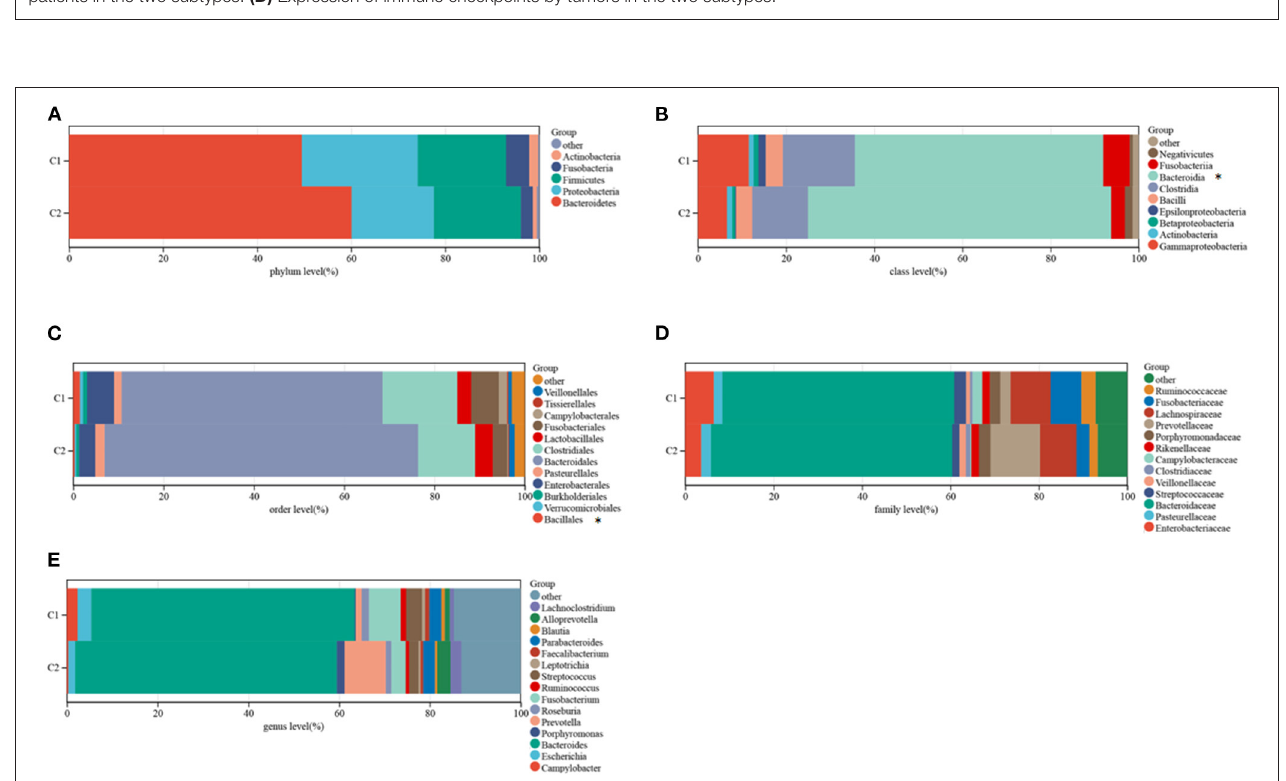
FIGURE 4 | Composition of microbiota in the two subtypes at the phylum (A) , class (B) , order (C) , family (D) , and genus (E) levels.